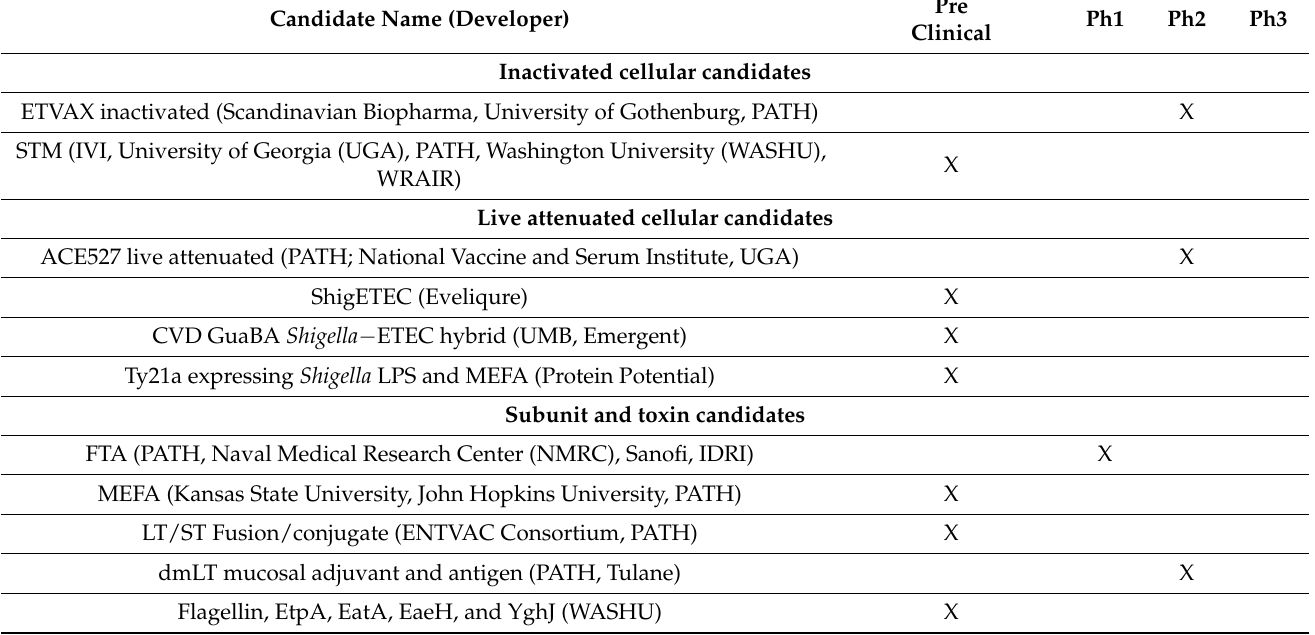
Table 2. Enterotoxigenic Escherichia coli (ETEC) vaccine candidates (in development or previously found efficacious). Candidate Name